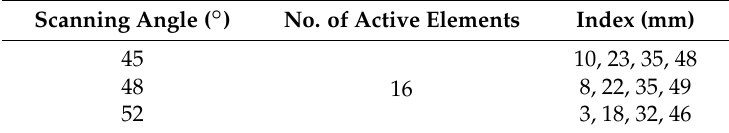
Table 6. Number of active elements, scanning angles and indexes of inspection procedures with an